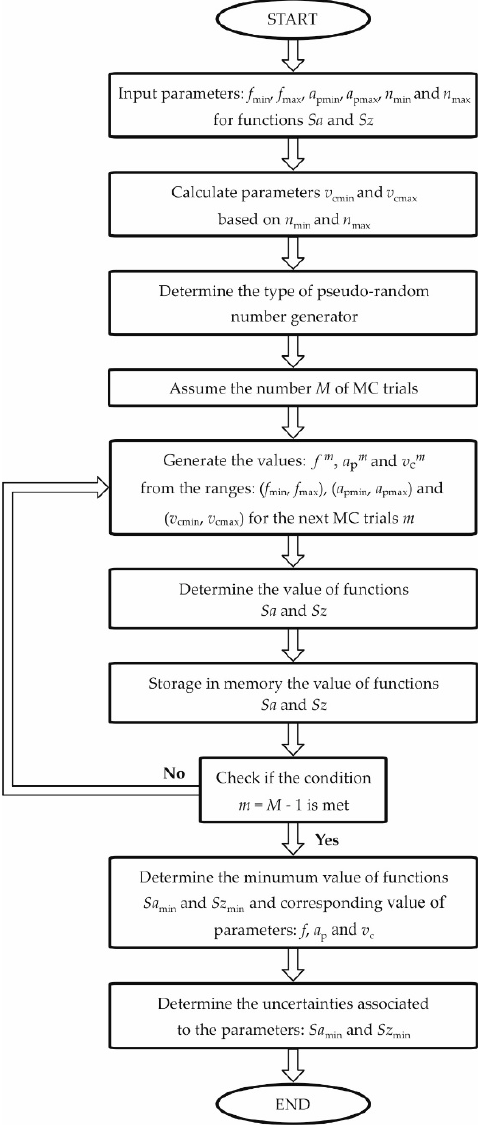
Figure 1. Block diagram of the applied MC method.